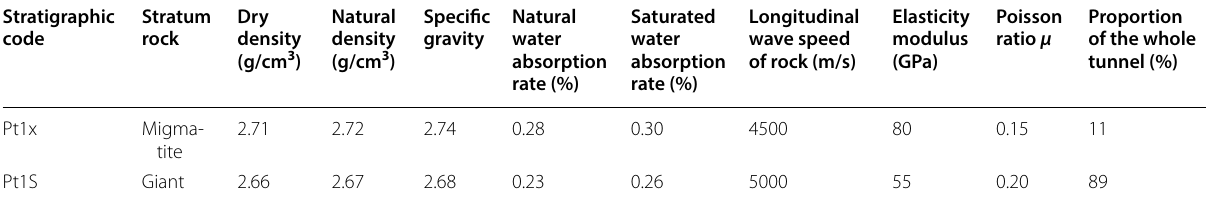
Table 1 Physical parameters of two kinds of rock Stratigraphic code